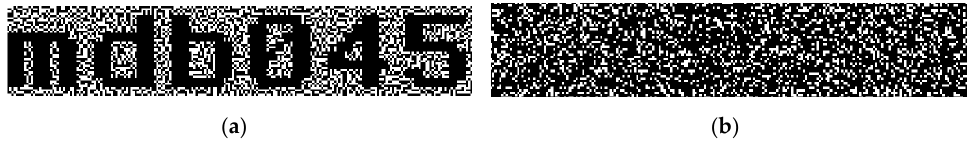
Figure 9. Revealed identities after the overlapping of ( a ) original shares S 1 and S 2 and ( b ) embedded shares W S1 and W S 2